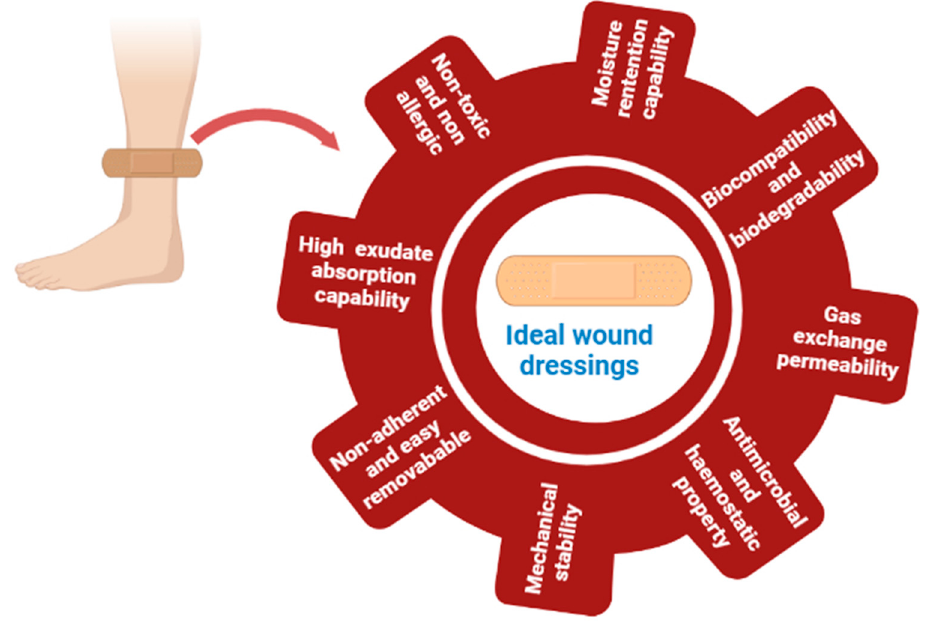
Figure 3. Prerequisite characteristics of ideal wound dressings.